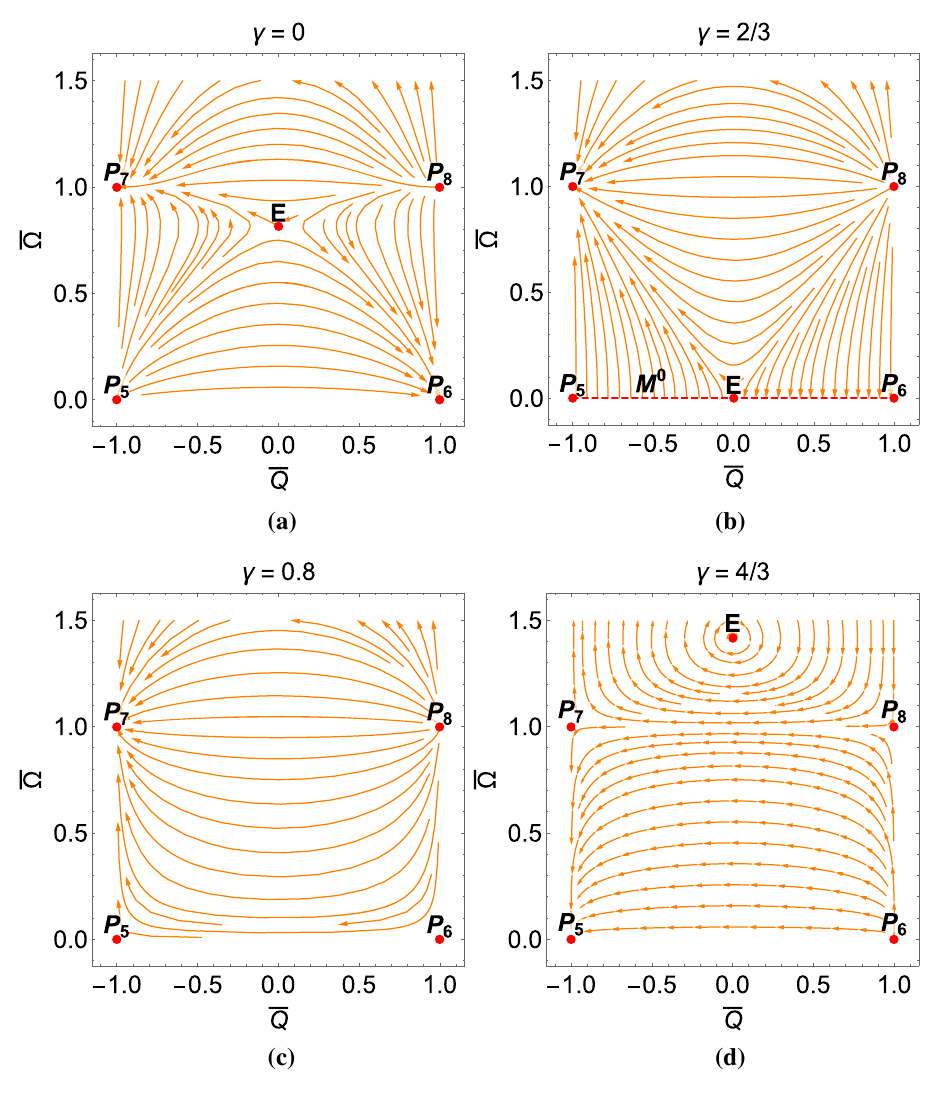
Fig. 7 Phase plane for system (145a), (145b) corresponding to closed FLRW for different choices of